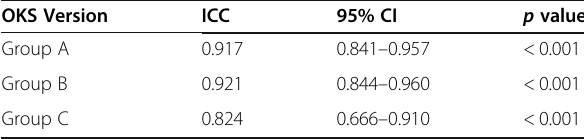
Table 2 Test and retest reproducibility for 3 OKS versions